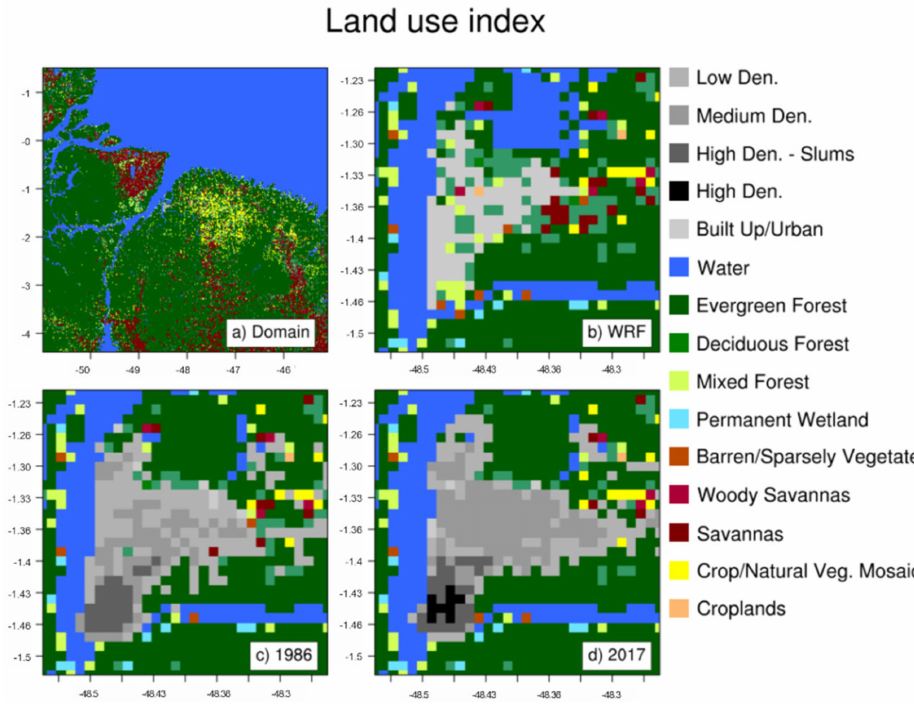
Figure 2. Weather Research and Forecasting (WRF) land use categories. ( a ) entire domain; ( b ) WRF default categories; ( c ) BMR urban area as in 1986; ( d ) BMR area as in 2017. The solid black lines represent the real geography of the